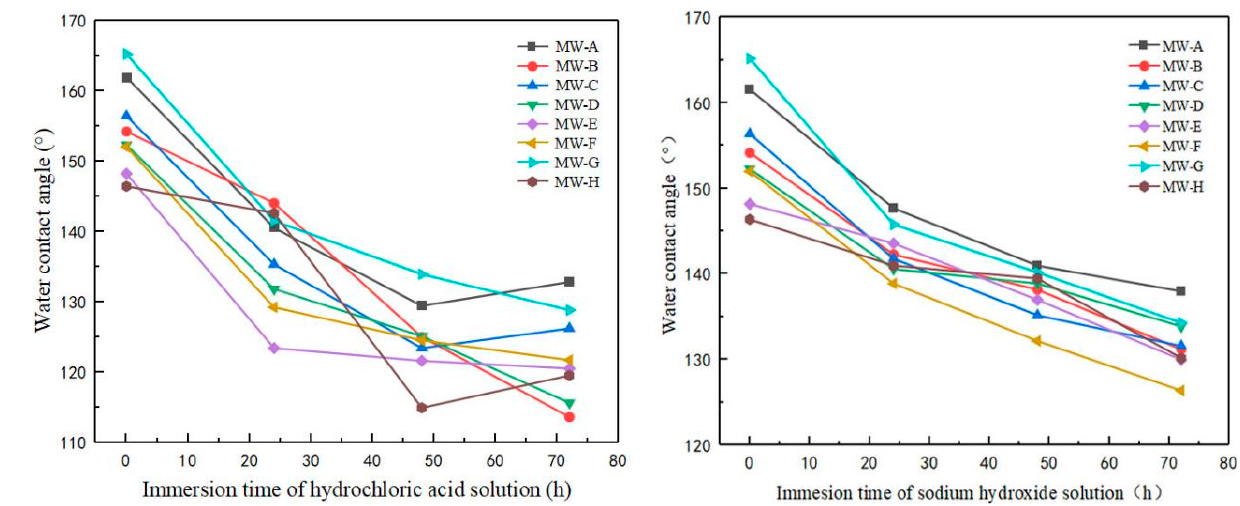
Figure 12. Acid and alkali resistance test of modified wood ( a ) HCl solution (pH = 1) and ( b ) NaOH solution (pH = 12).